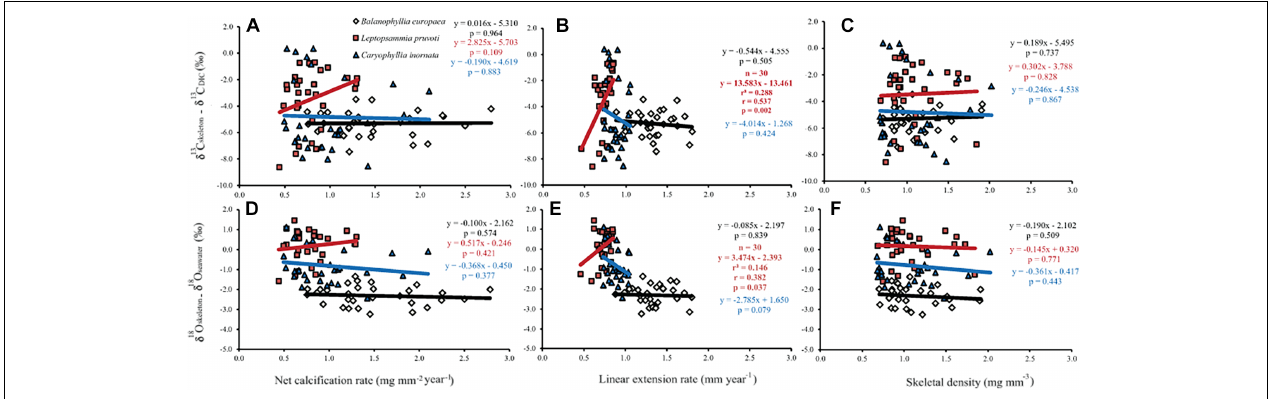
FIGURE 7 | The relation between skeletal δ 13 C and δ 18 O and net calcification rate (mg mm − 2 yr − 1 ; A,D ), linear extension rate (mm yr − 1 ; B,E ) and skeletal bulk density (mg mm − 3 ; C,F ) in B. europaea , L. pruvoti , and C. inornata at 6 sites along the west coast of Italy ( ∼ 850 km transect). Net calcification rate, linear extension rate and skeletal density data were taken from Goffredo et al. (2009) and Caroselli et al. (2012a, 2016b). r 2 , Pearson’s coefficient of determination; r , Pearson’s correlation coefficient; n , number of